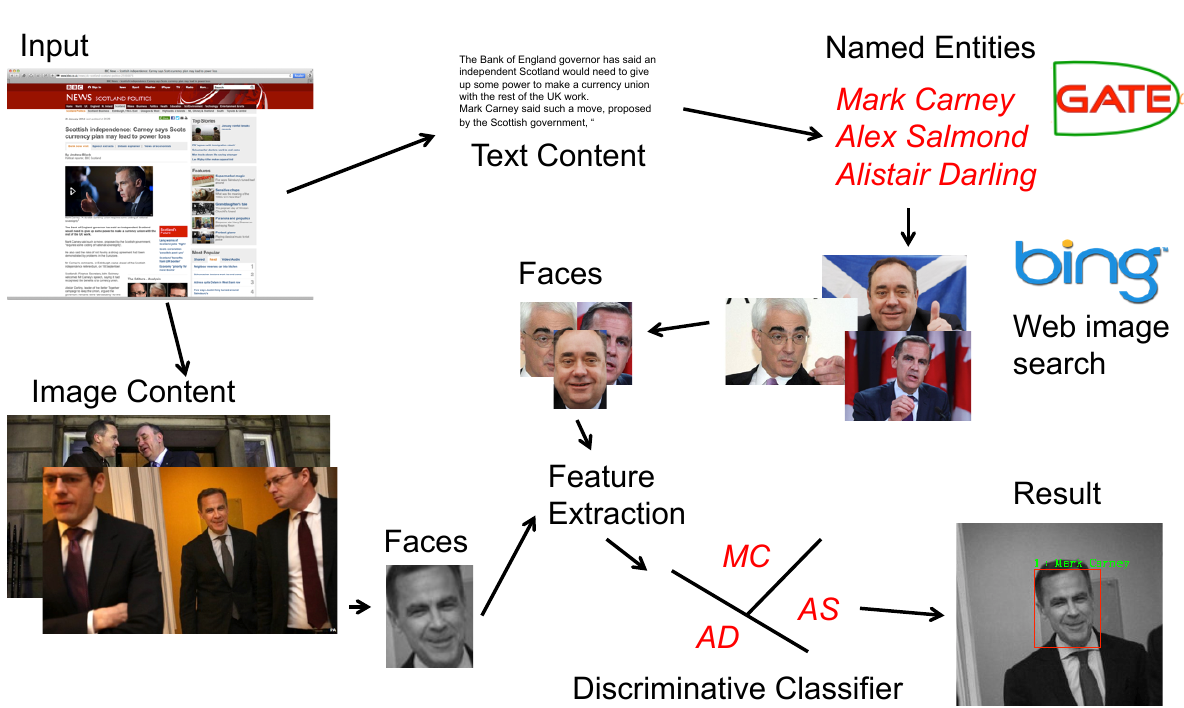
Figure 5. Illustration of how face recognition is used to detect entities by dynamically training the recogniser based on person entities detected in the textual content of the